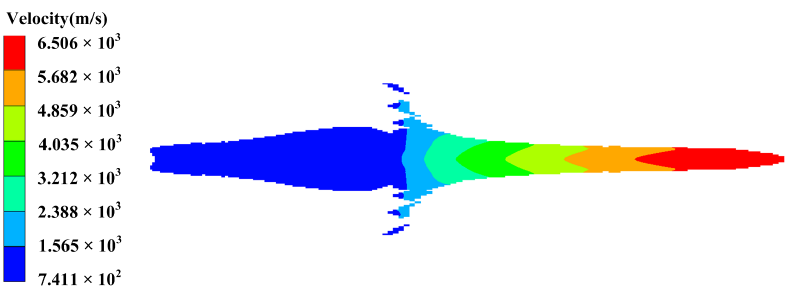
Figure 6. SC finite element model.